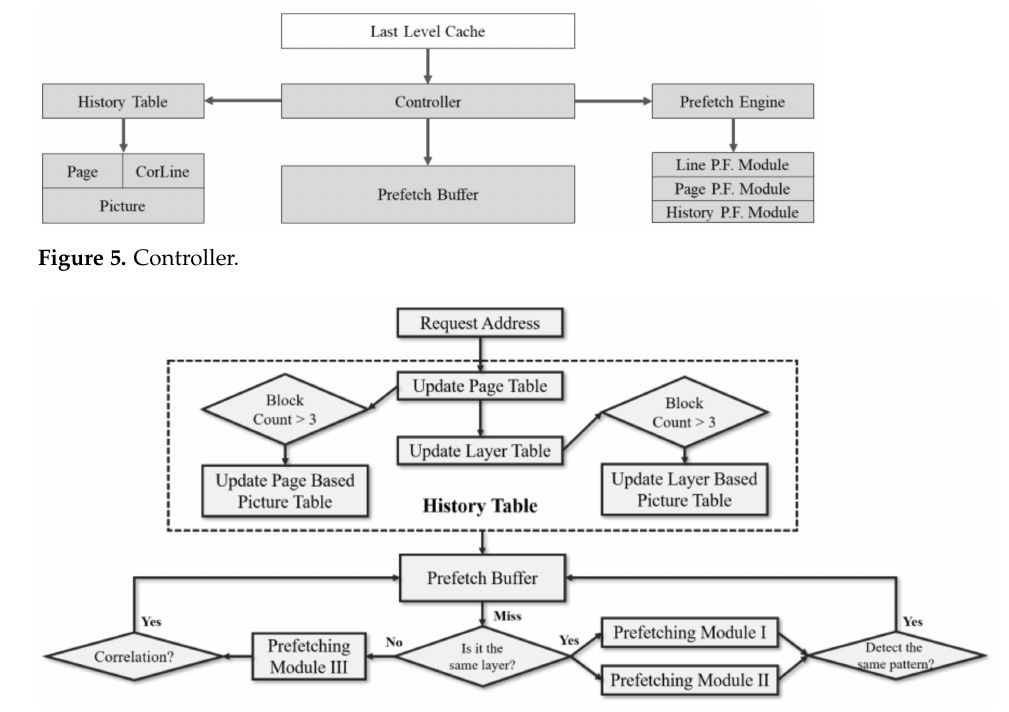
Figure 6. Operational flow of prefetch